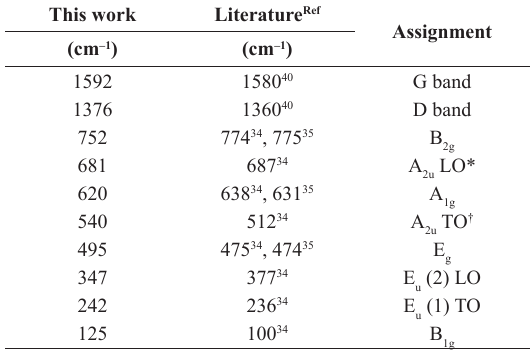
nanocomposite. This